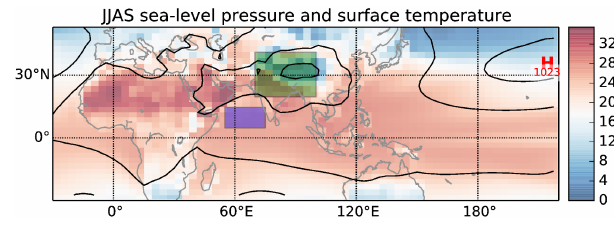
Figure 4. JJAS sea-level pressure and surface temperature of the two regions depicted: NI and IO. Units are in ◦